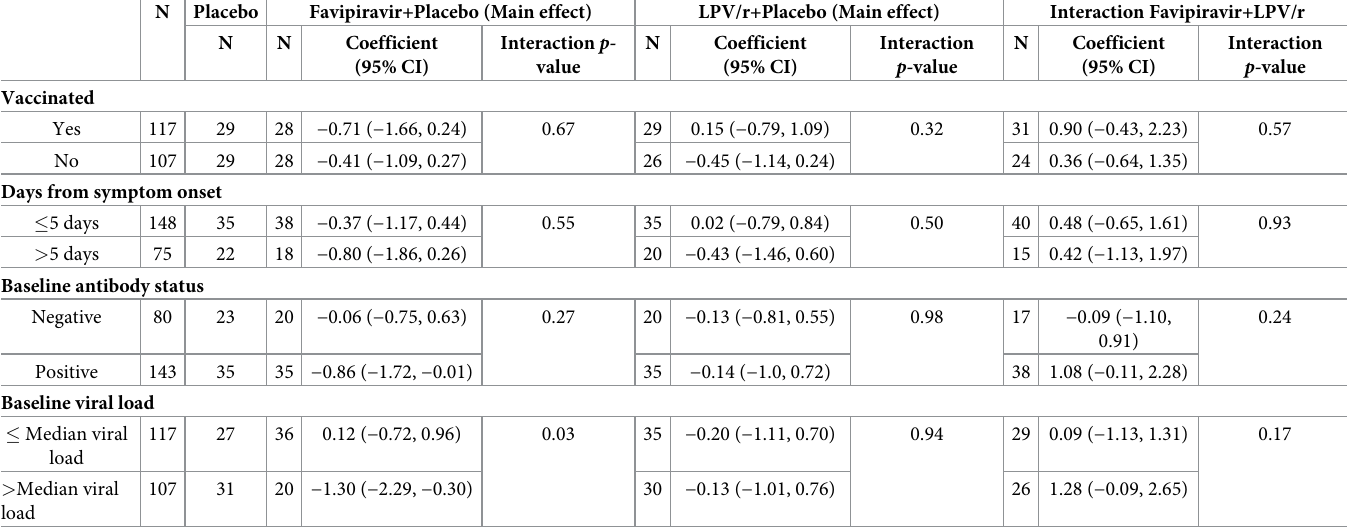
Table 5. Subgroup analyses for primary outcome according to vaccination status, duration of symptoms, baseline antibody status, and baseline viral load. N Placebo